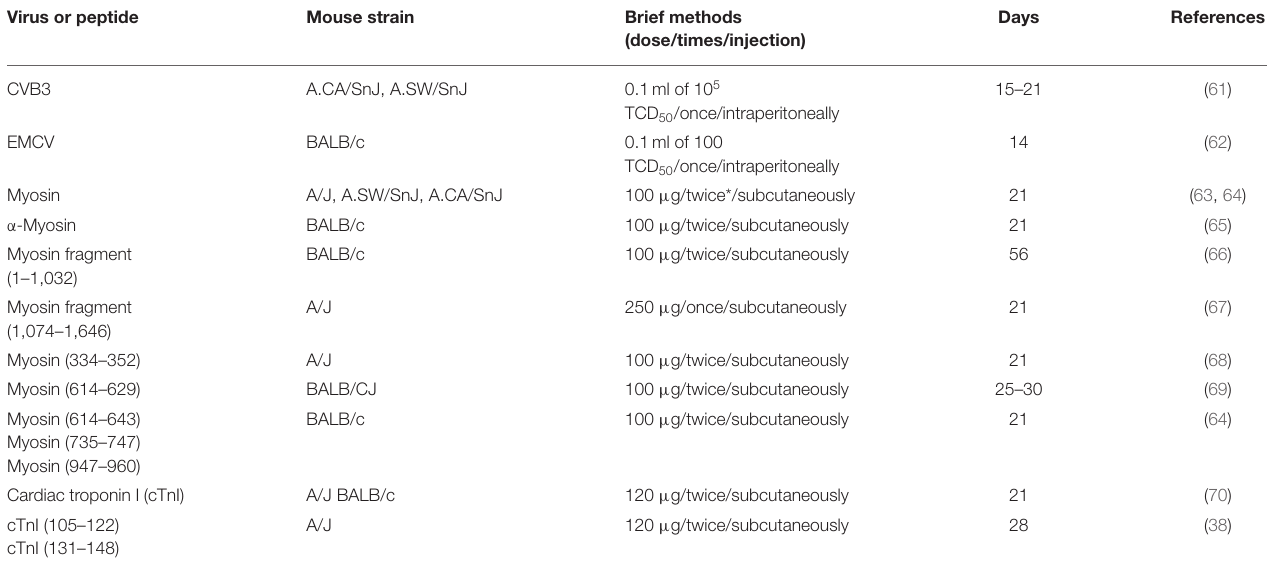
TABLE 3 | Overview of various autoimmune myocarditis models. Virus or